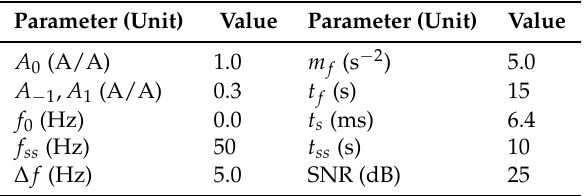
Table 1. Values used for the synthetic signal s ( t ) in (14).